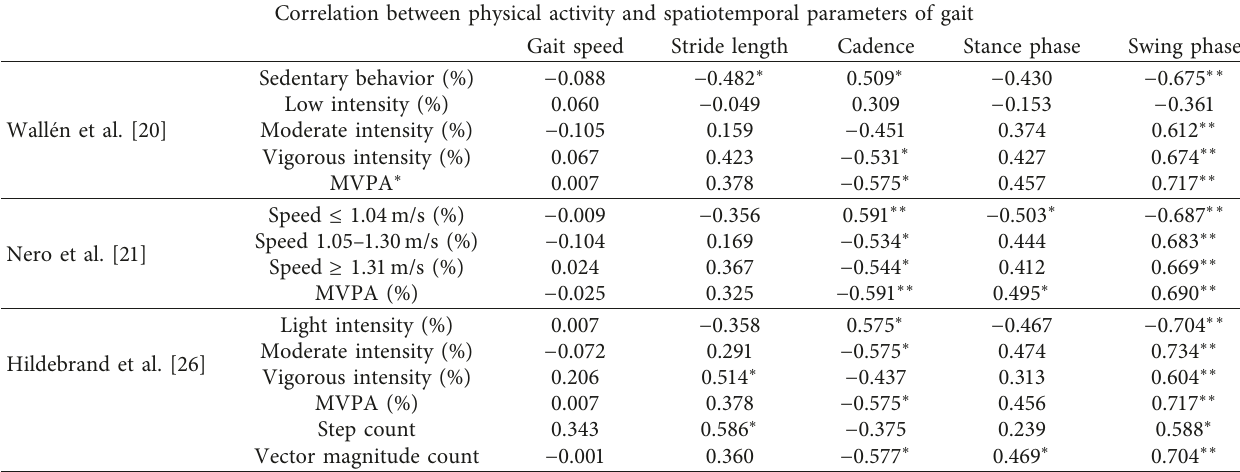
Table 5: Spearman’s correlation analysis between physical activity intensity and spatiotemporal parameters of gait. Correlation between physical activity and spatiotemporal parameters of gait